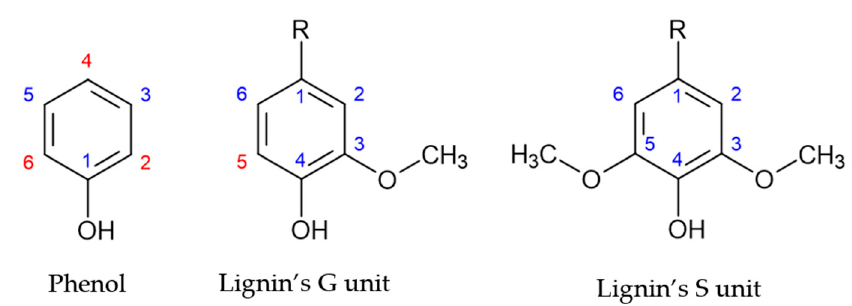
Figure 1. Reactive sites of phenol and lignin’s phenolic units (adapted from [2]).